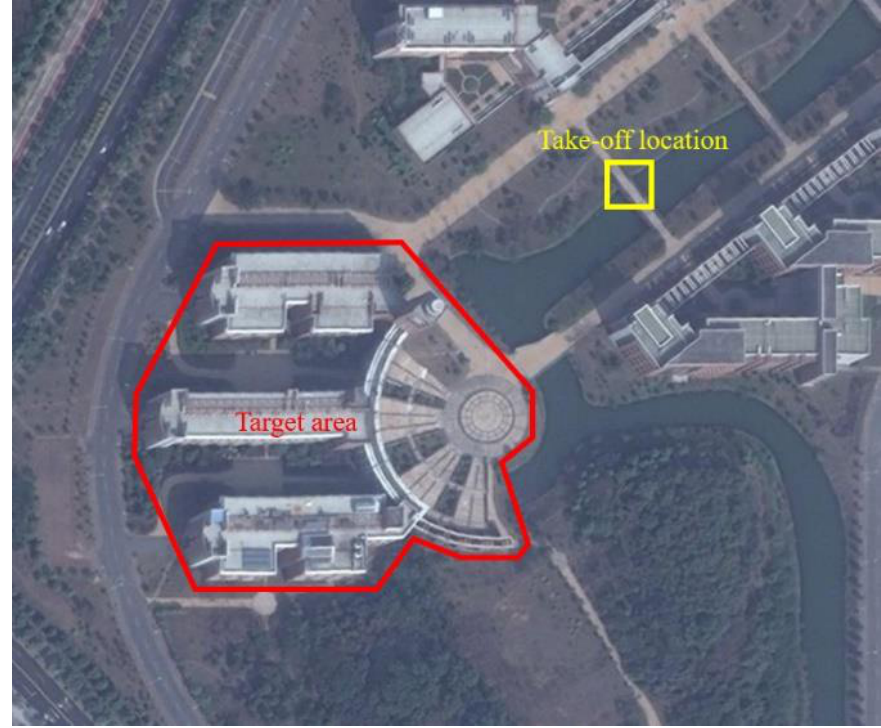
Figure 8. GPS map of the target area and the take-off location. Two UAVs were employed to take photos in this experiment. The head direction of the UAVs is locked to the initial direction since they would consume extra energy when turning. Under this operation mode, UAVs can change their directions by adjusting the speed of different motors and save much energy. A bridge near the target area was selected as the take-off location based on safety considerations (shown in yellow in Figure 8). We adopted the same hardware and experimental conditions when comparing the proposed method and a zigzag path planning method. The relevant parameters of the experiments are listed in Table 1. These parameters are the same in both the SAA path experiment and zigzag path experiment. Table 1. Parameters of the